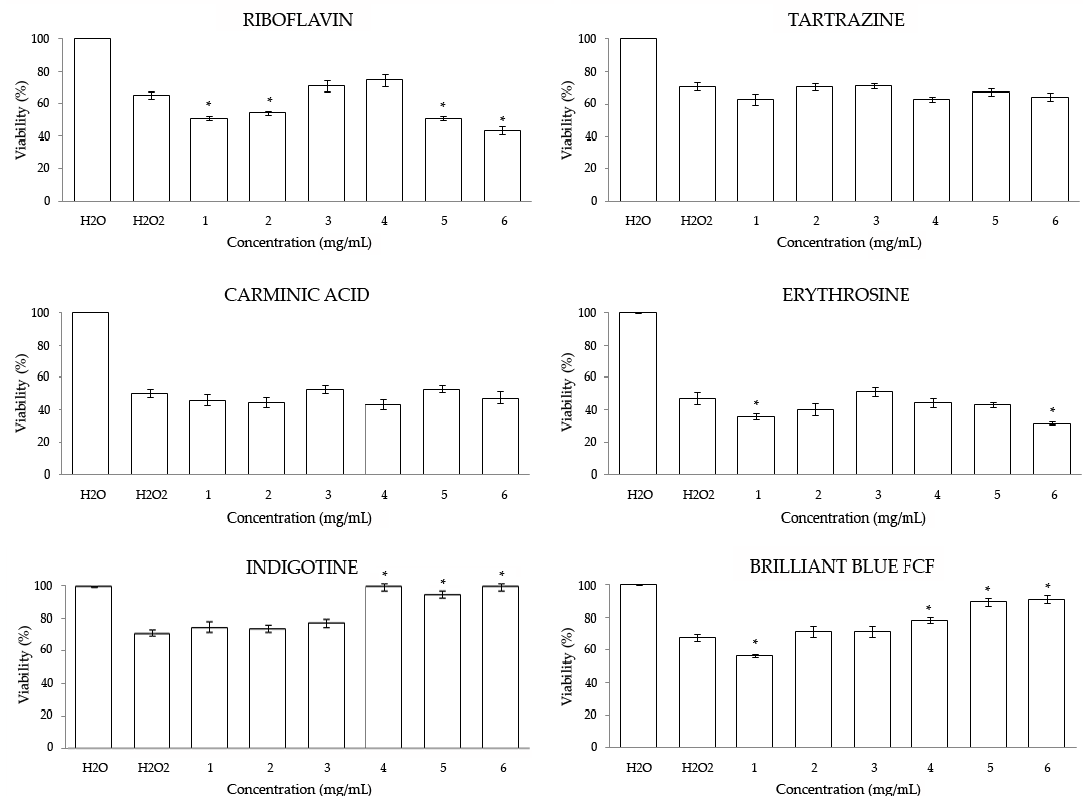
Figure 2. Antitoxicity levels of food coloring in D. melanogaster . Data are expressed as percentage of surviving adults with respect to 300 untreated 72 h-old larvae from three independent experiments treated with different concentrations of food colorings combined with 0.12 M H 2 O 2 . Values represent the mean ± SE from three independent experiments. * Indicates significant differences with respect to the positive control. 1–6 numbers indicate the different dilutions tested (see Table 1).